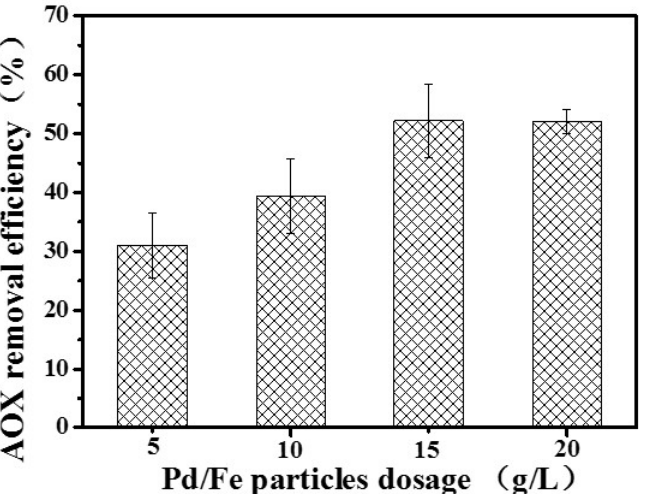
Figure 5. The e ffect of added amounts of Pd/Fe on the removal efficiency of AOX (Pd loading = 0.05 wt %, pH 6.0; reaction time was 10 0.05 wt %, pH 6.0; reaction time was 10 days).